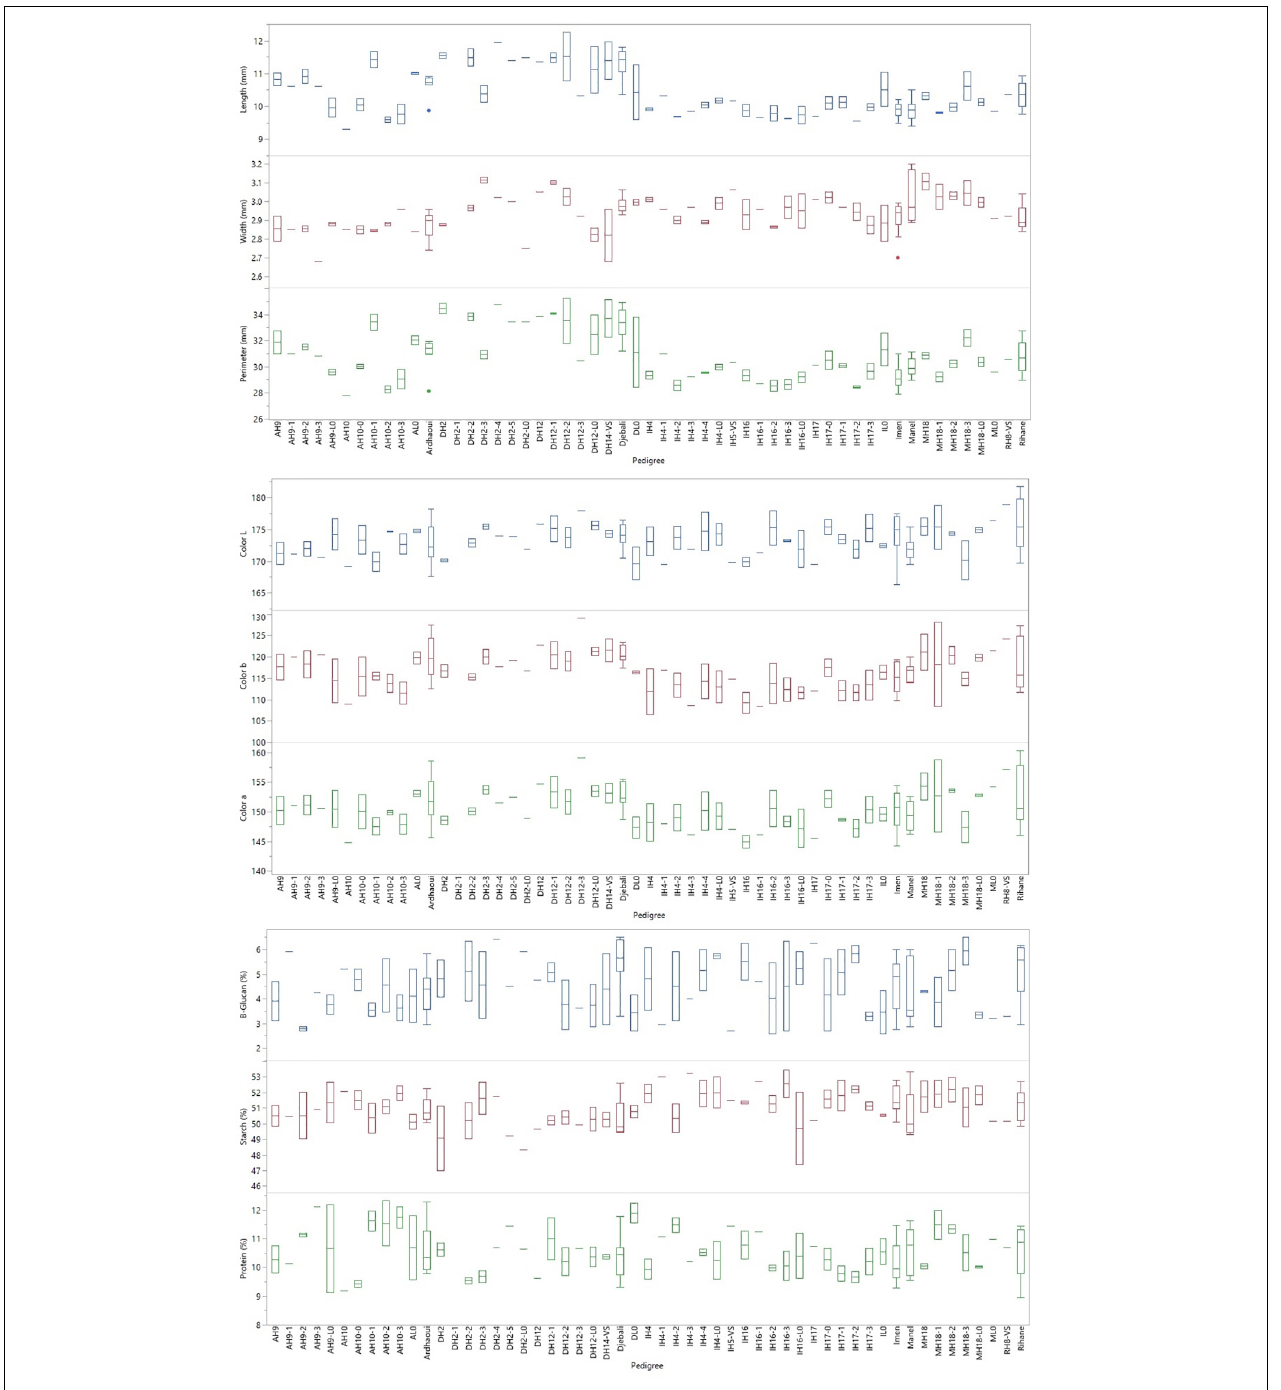
FIGURE 5 | Entry box plots for the grain quality parameters measured during the evaluation of the barley lines in the distinct environments in